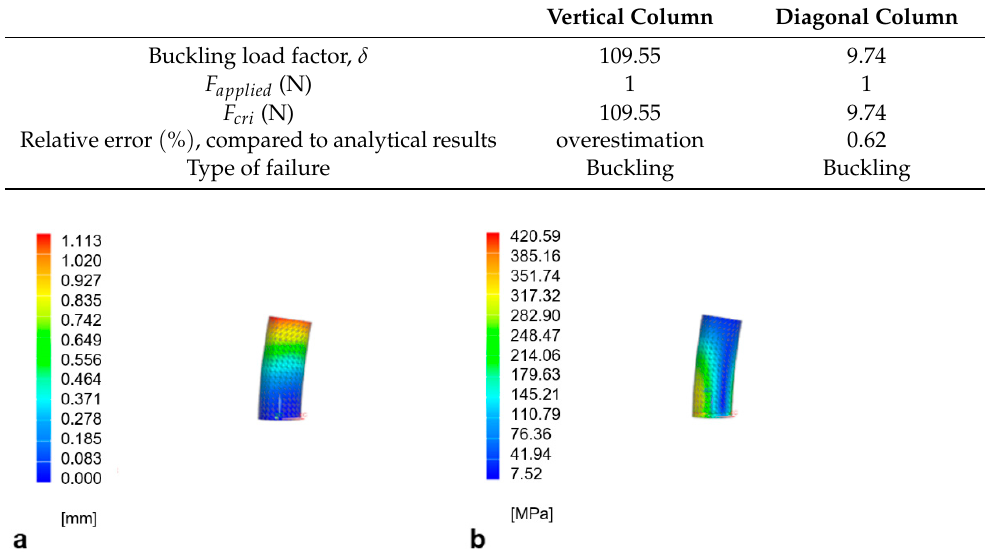
Figure 7. Displacement ( a ) and stress distribution ( b ) of the vertical column with free–fixed boundary condition in the buckling analysis.